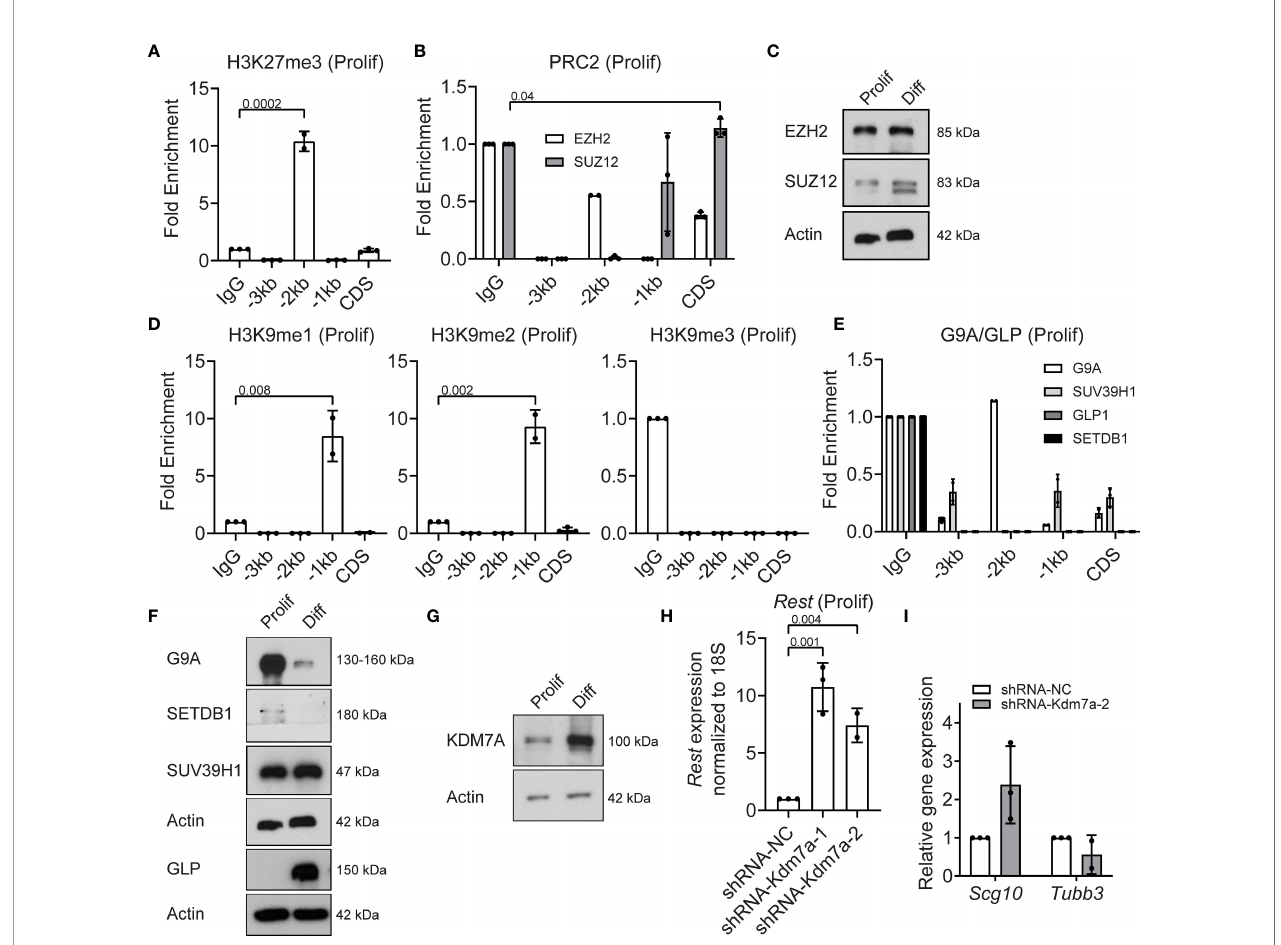
FIGURE 3 | PRC2 and G9A/GLP complexes and Kdm7a repress REST expression in proliferating progenitors. (A) Enrichment of H3K27me3 over IgG at Rest promoter in proliferating CGNPs measured by ChIP-qPCR. Bars represent fold change of H3K27me3 over IgG in the samples. (B) Enrichment of EZH2 and SUZ12 by ChIP from proliferating progenitors were plotted as fold change over IgG in the samples. (C) Western blot analysis of PRC2 complex proteins EZH2 and SUZ12 from proliferating and differentiating progenitors. Data shown is a representative blot from progenitors isolated from 6 mice. (D) H3K9me1, 2 and 3 changes in proliferating progenitors were measured by ChIP-qPCR and represented as fold change over IgG. Bars represent fold change of H3K9me over IgG in the samples. (E) Enrichment of G9A, GLP, SUVAR39H1 and SETDB1 were measured by ChIP-qPCR and plotted as fold change over IgG. (F) Western blot showing G9A/GLP complex proteins in proliferating and differentiating progenitors normalized to Actin. Shown blot is a representative from n =2. (G) Western blot of KDM7A protein levels in proliferating and differentiating progenitors compared to Actin control. Shown is a representative blot from n = 2. (H) Knockdown of Kdm7a using shRNA speci fi c to Kdm7a was performed and Rest transcript was measured 48 hours post shRNA addition (n=2). (I) mRNA levels of Scg10 and Tubb3 after Kdm7a knock down is shown in proliferating progenitors. For all of the ChIPs shown (unless otherwise speci fi ed) GNPs from 6 mice for proliferating conditions were pooled and the chromatin was isolated followed by